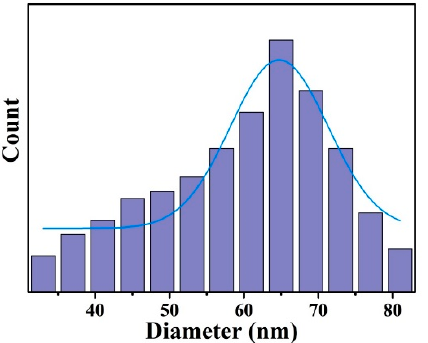
Figure 2. The statistical distribution of particle size of Ag NPs.